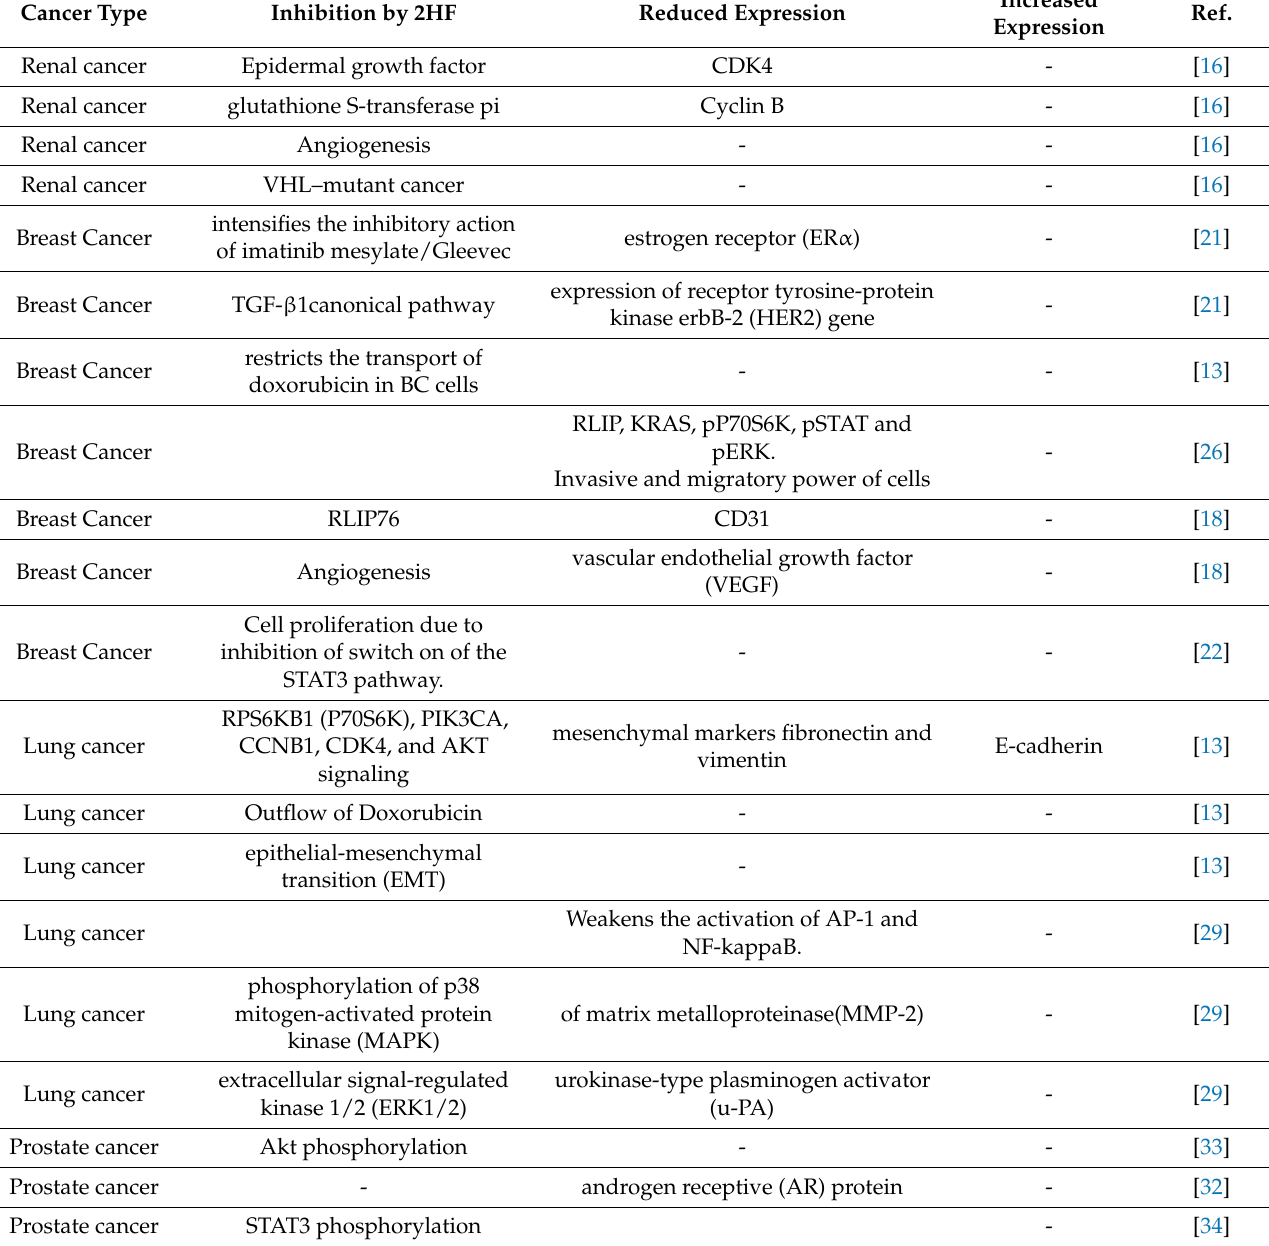
Table 1. Modulatory effects of 2-Hydroxyflavanone on the expression of certain genes and proteins involved in